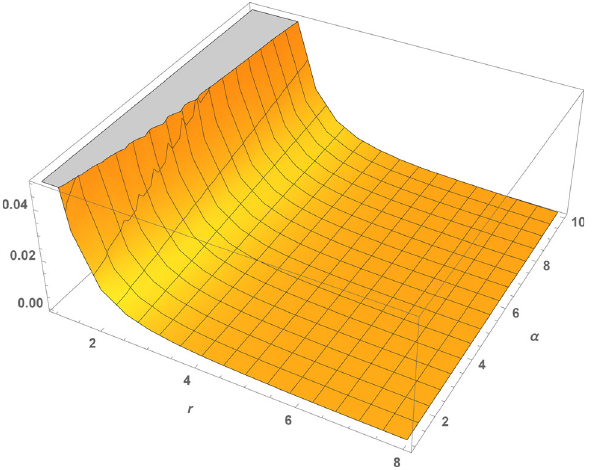
Fig. 12 Validationofstrongenergycondition(SEC), ρ + p r + 2 p t ≥ 0, for λ = − 35 and different α